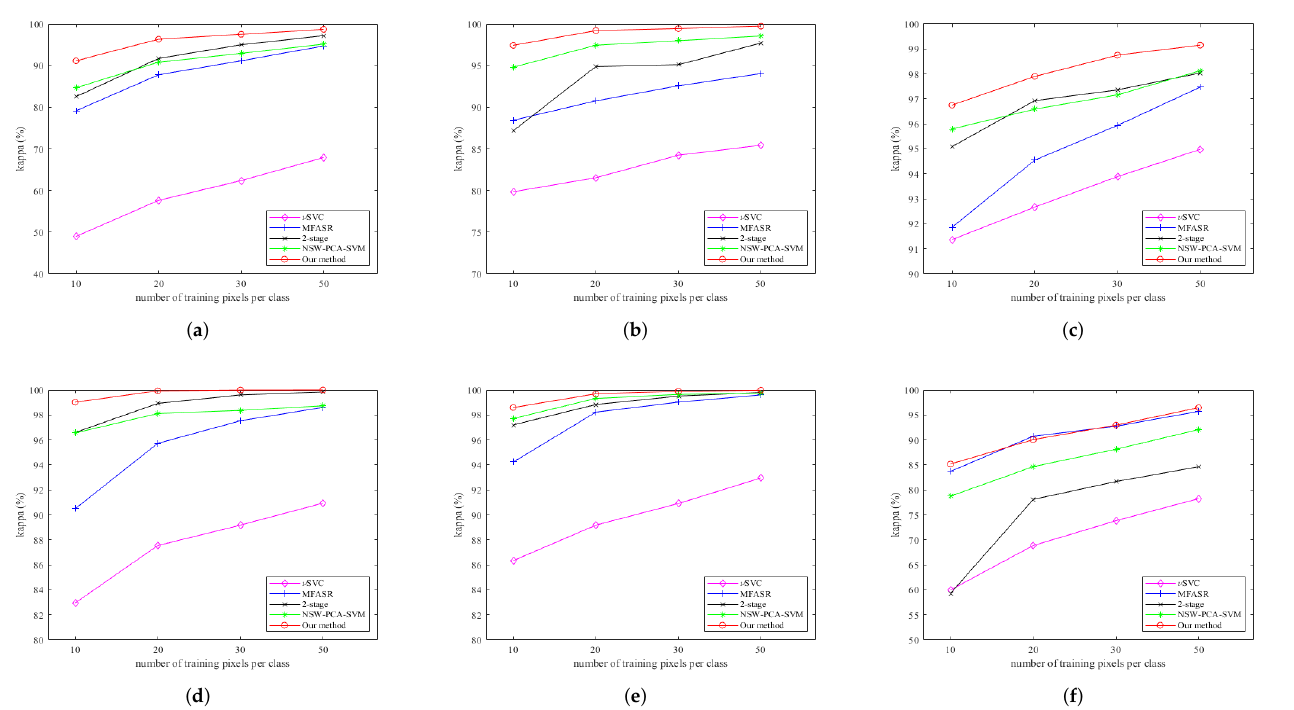
Figure 8. Kappas ( y -axis) for different datasets with a different number of training pixels ( x -axis). ( a ) kappa on the Indian Pines dataset; ( b ) kappa on the Salinas dataset; ( c ) kappa on the Pavia Center dataset; ( d ) kappa on the KSC dataset; ( e ) kappa on the Botswana dataset; ( f ) kappa on the PaviaU